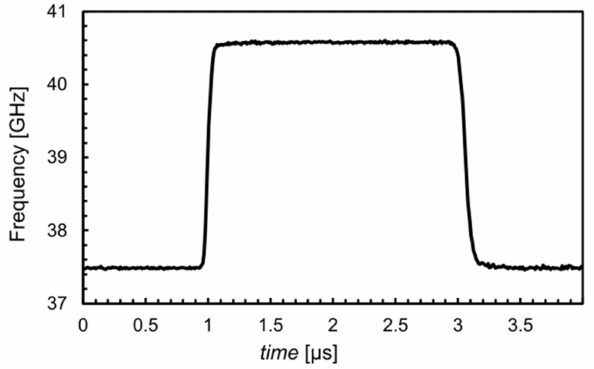
Figure 8. Transient response of the VCO oscillation frequency with 5-MHz PLL bandwidth.